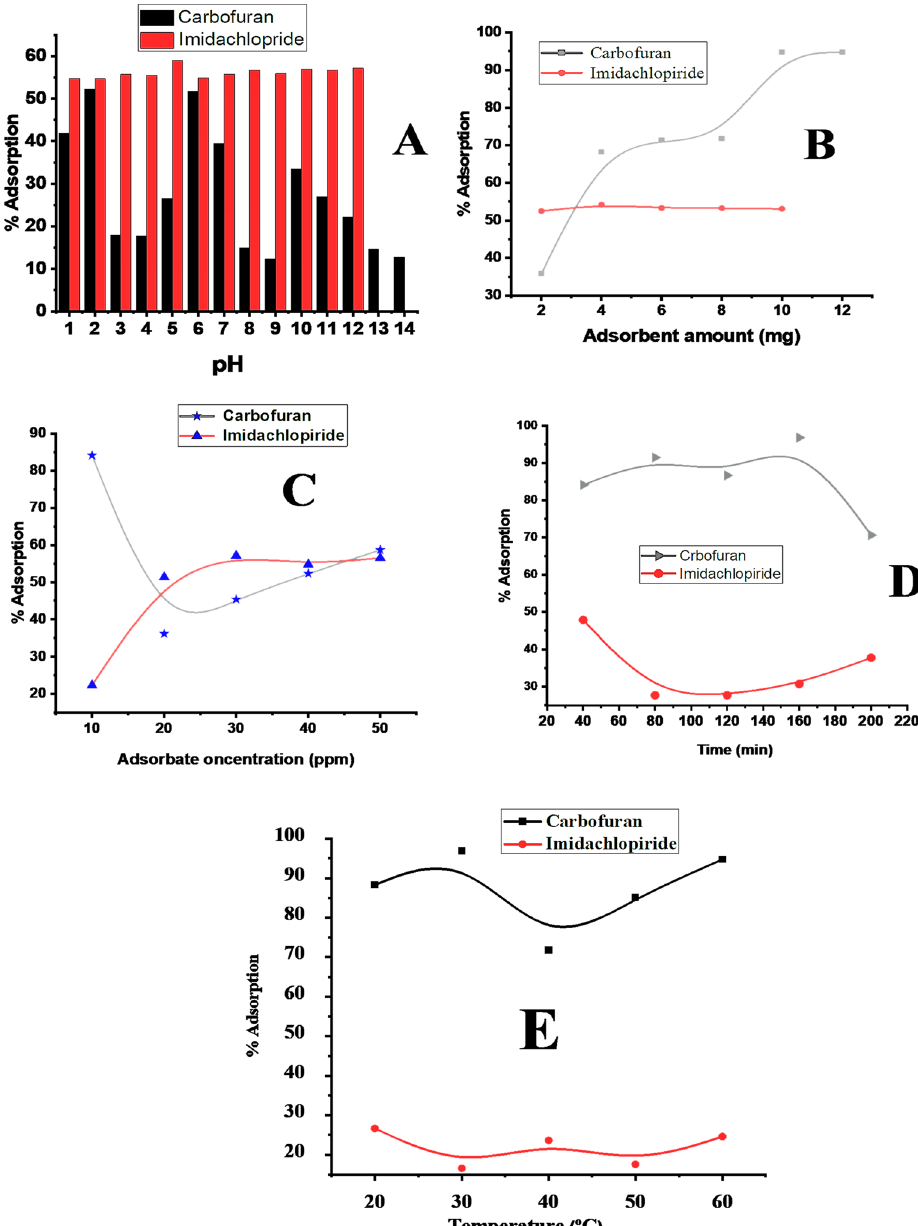
Figure 7. Effect on % adsorption of carbofuran and imidacloprid: pH ( A ); adsorbent dose ( B ); amount of adsorbate ( C ); shaking time ( D ); temperature effect ( E ) during the adsorption on composite